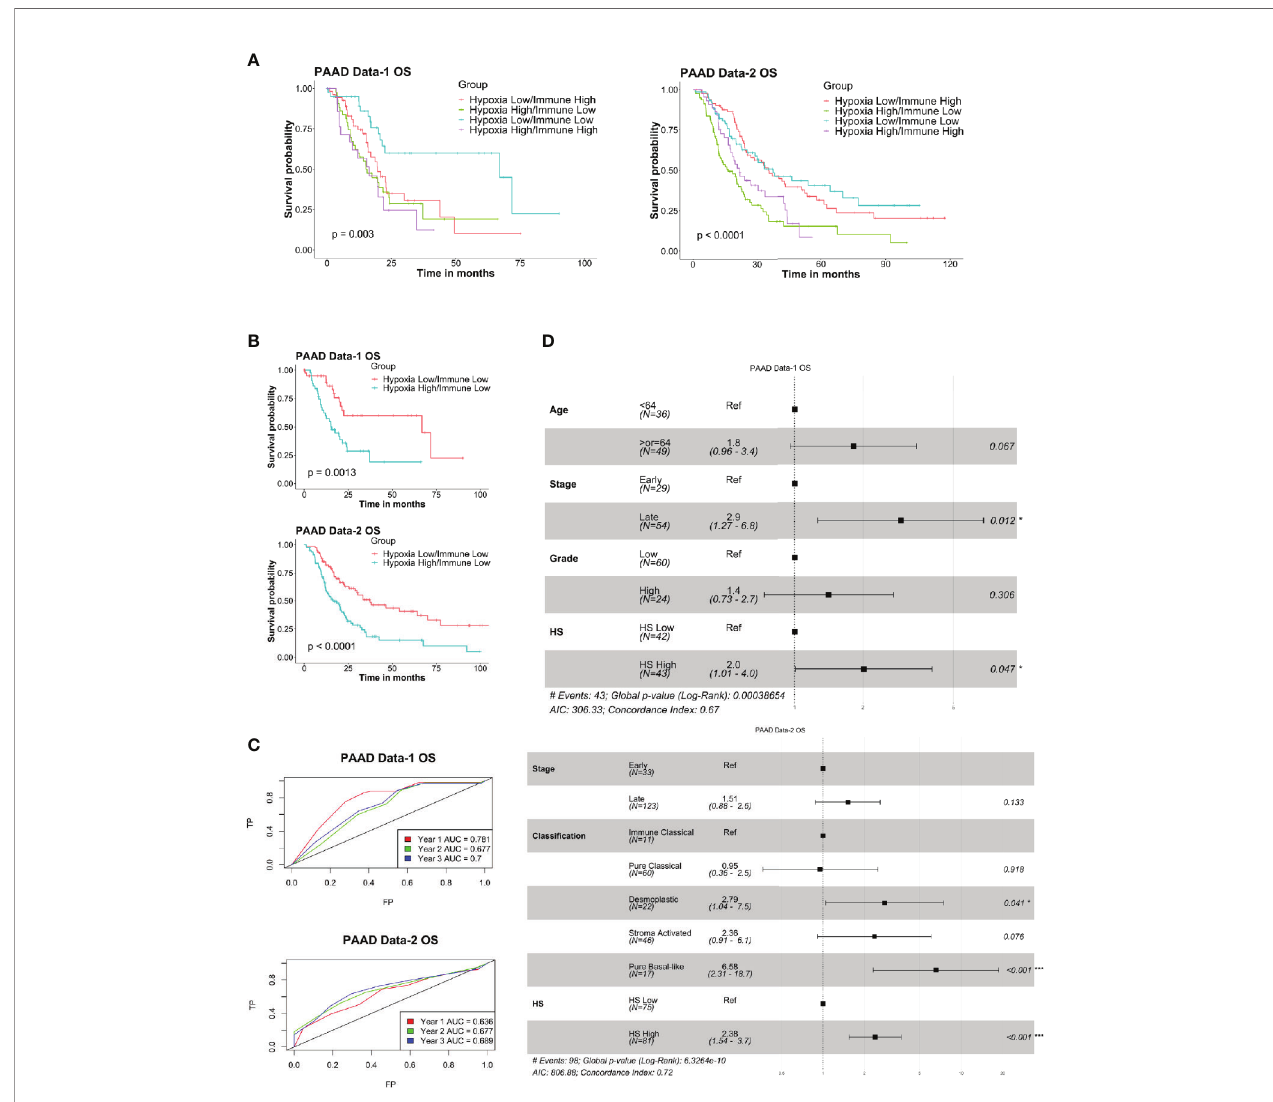
FIGURE 5 | Prognostic and predictive ef fi ciency of a combined hypoxia and immune classi fi cation in pancreatic cancer: (A) Kaplan-Meier survival plots with log-rank test, comparing the groups divided based on both hypoxia score and immune score. (B) Kaplan-Meier survival plots with log-rank test, comparing the two groups of Hypoxia Low/Immune Low and Hypoxia High/Immune Low. (C) ROC curves depicting the predictive ef fi ciency of the hypoxia signature on OS considering the 1-, 2-, and 3- years survival rates in the two groups. (D) Multivariate COX PH forest plots showing hazard ratio of OS considering the 8-gene HS and other clinical covariates in the two groups. P-values < 0.05 considered statistically signi fi cant. OS, overall survival; AUC, area under the curve; FP, false positive (1 - speci fi city); TP, true positive